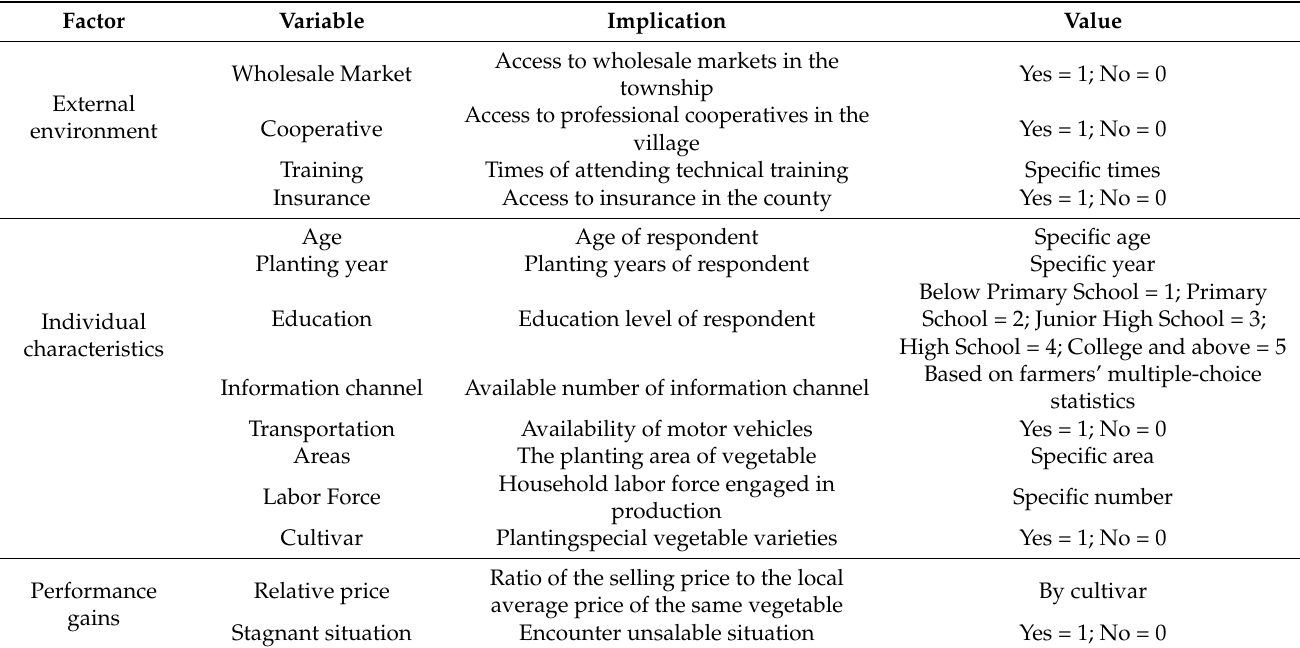
Table 1. Variables used in this